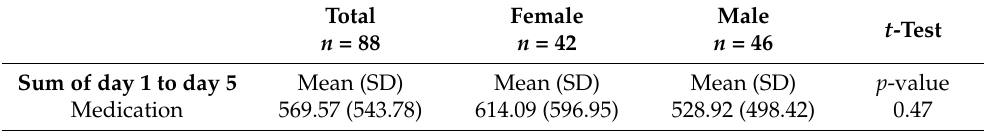
Table 4. Total amount of medication in mg MED from day 1 to day 5 after operation by